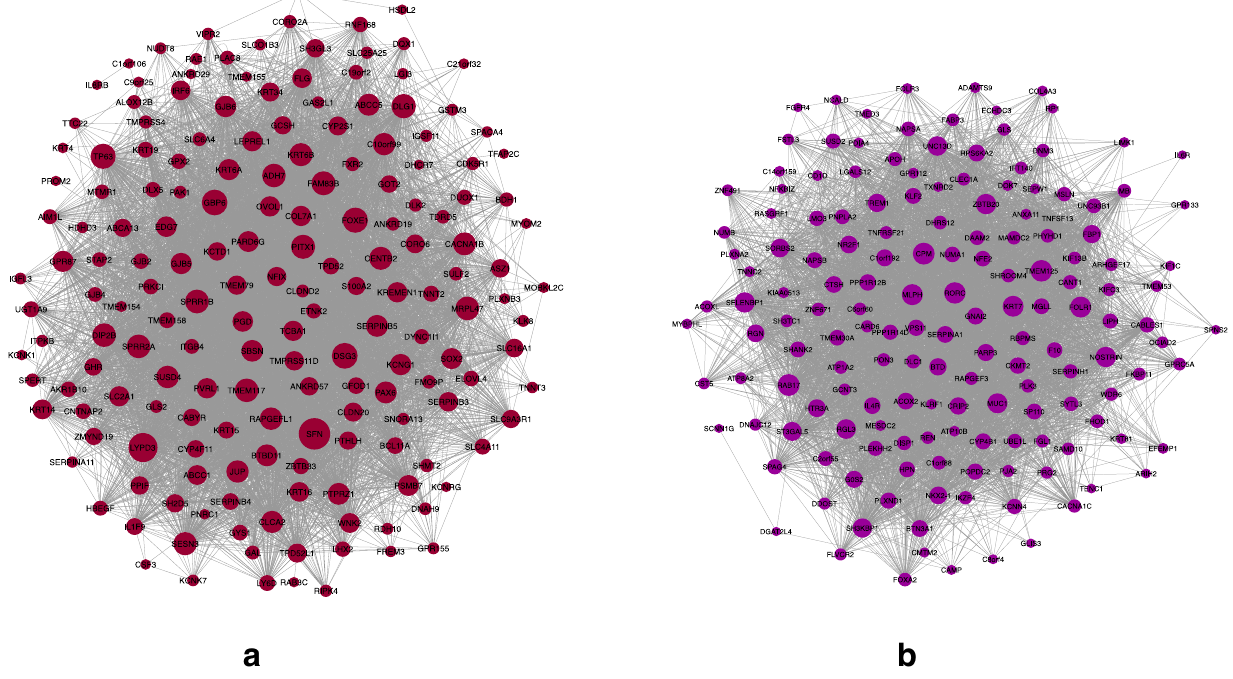
Figure 2. Magenta (a) and Purple (b) modules. The circle nodes represent genes (this figure was drawn in the Cytoscape 43 v.3.8.2 software).